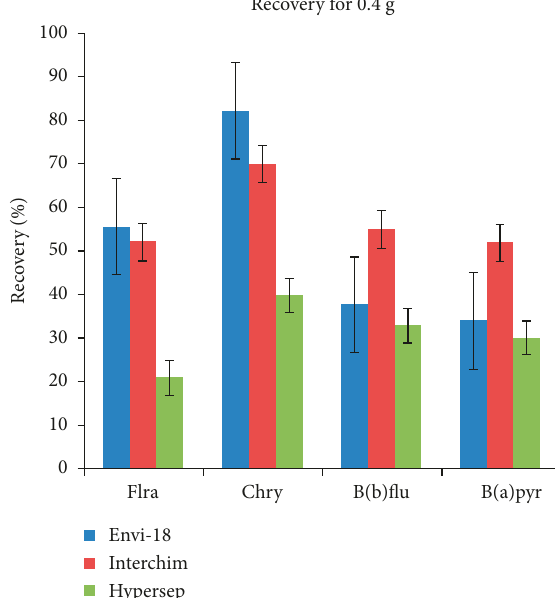
Figure 2: Comparison of different sorbents using a dosage of 0.4 grams: fluoranthene (Flra), chrysene (Chry), benzo(b)fluoranthene